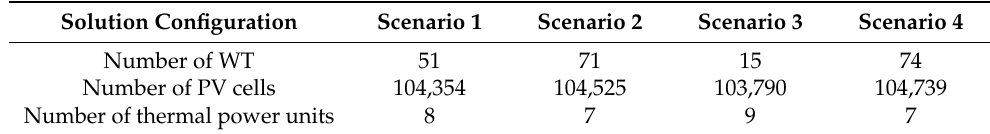
Table 3. Different capacity configuration